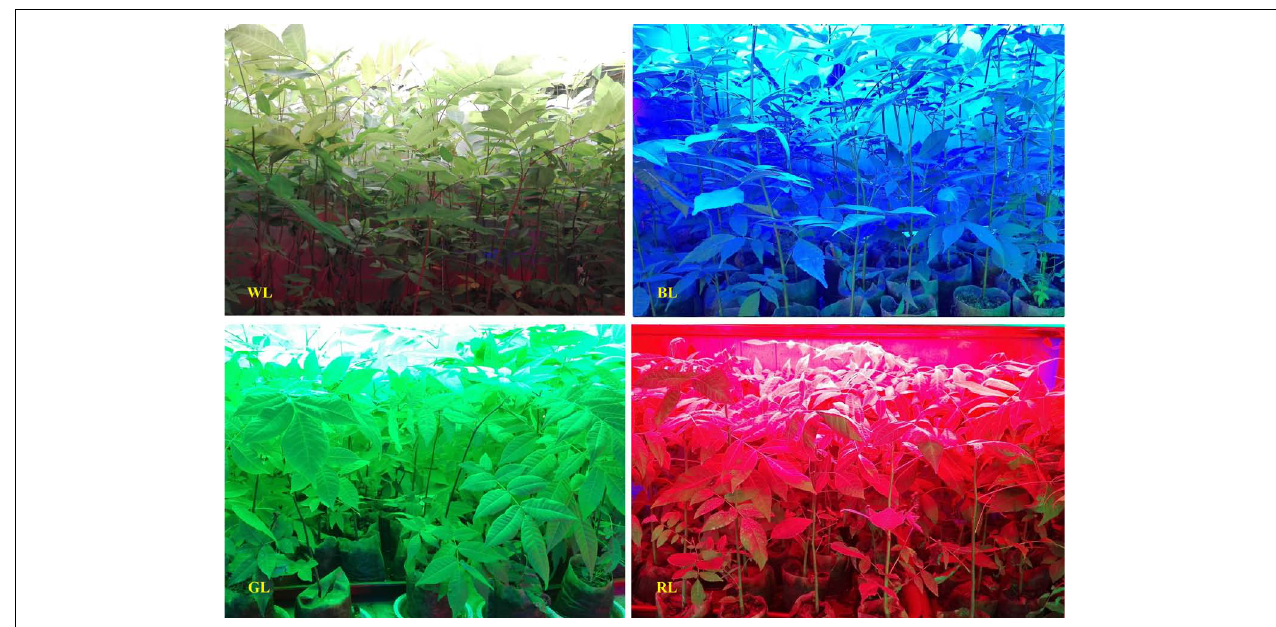
FIGURE 1 | Cyclocarya paliurus plants under different LED light treatments (80